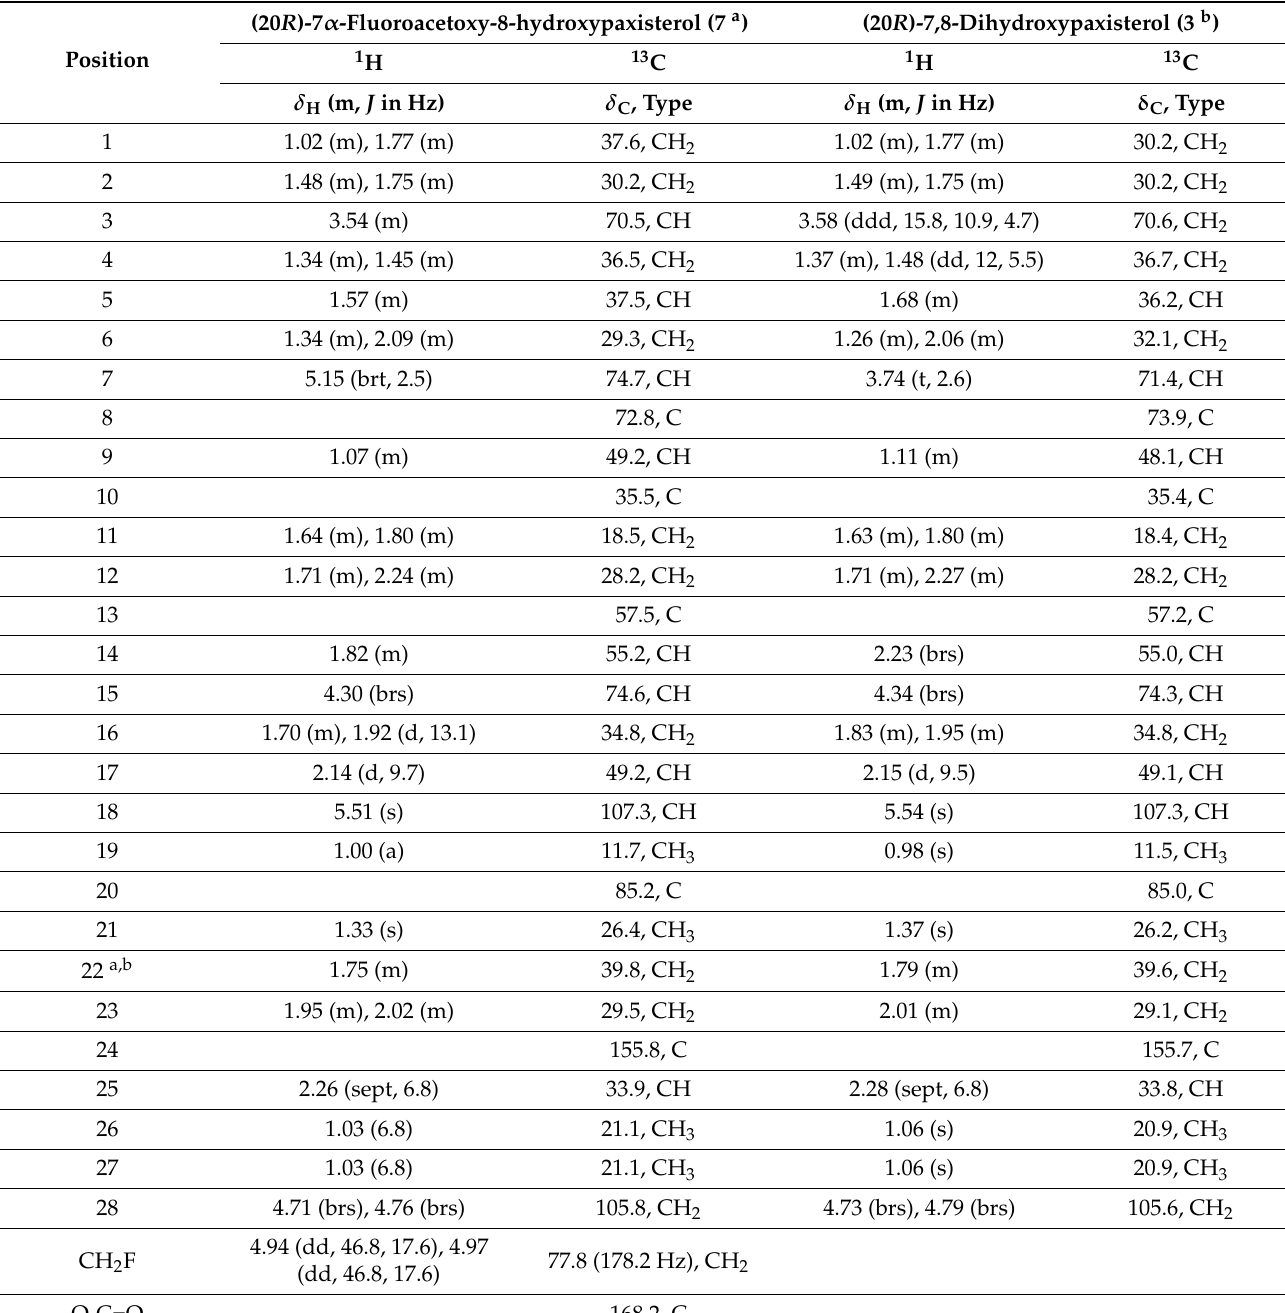
Table 1. 1 H and 13 C NMR NMR spectroscopic data for compounds 7 and 3